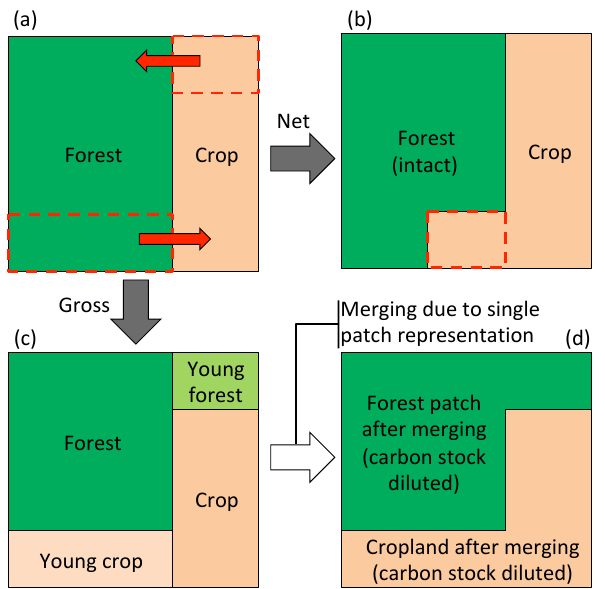
Figure 1. Schematic illustration of gross versus net land use change, with each land cover type being represented using a single patch within a model grid cell. The figure is adapted from Stocker et al. (2014). (a) Original fractions of forest and cropland before land use transitions. Dashed red rectangles indicate areas subject to LUC and red arrows indicate land flow direction. Here LUC consists of a net loss in forest and a simultaneous bidirectional flow between forest and cropland. (b) Post-LUC fractions of forest and cropland following the original LUC scheme of net transitions only in OR- CHIDEE. Bidirectional land flow is omitted, with only cropland area being expanded to account for its net increase as a result of the net forest loss, as indicated by the dashed red rectangle. The soil carbon stock of the new cropland patch is an area-weighted mean between that of the original cropland and the legacy stock from the former forest. Carbon stock of the remaining forest patch is left in- tact. (c) Intermediate post-LUC land cover pattern after account- ing for gross transition. Both the net loss of forest and bidirectional land flows are accounted for, with two young patches of forest and cropland being established. (d) Final state of post-LUC land cover after accounting for gross LUC with no sub-grid cohorts. The car- bon stocks of the remaining (original) forest and the newly created forest are immediately merged following LUC because there are no sub-grid cohorts. The same applies for cropland as well. Note that although forest and cropland fractions are ultimately the same as in (b) , the carbon densities are different.